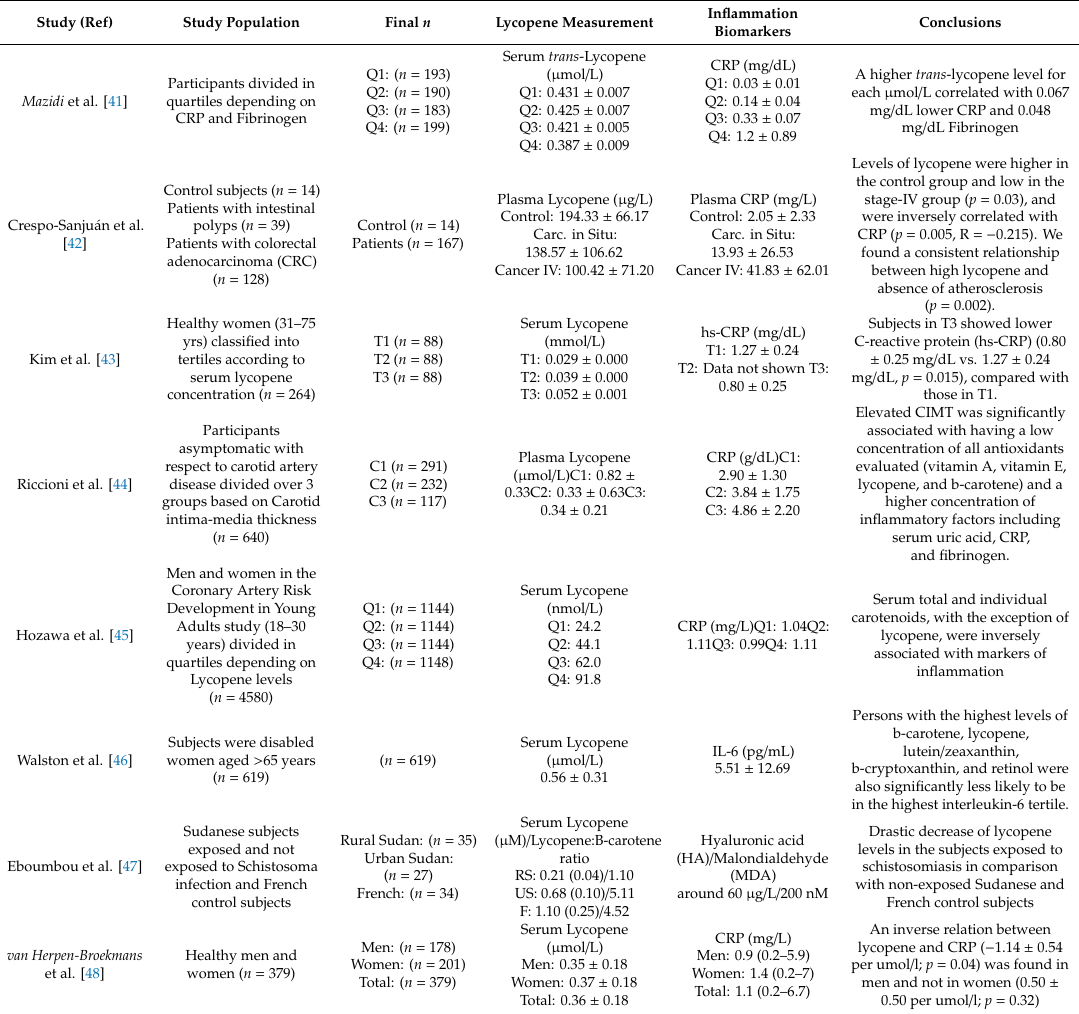
Table 1. Cross-sectional studies assessing the relation between circulating lycopene and